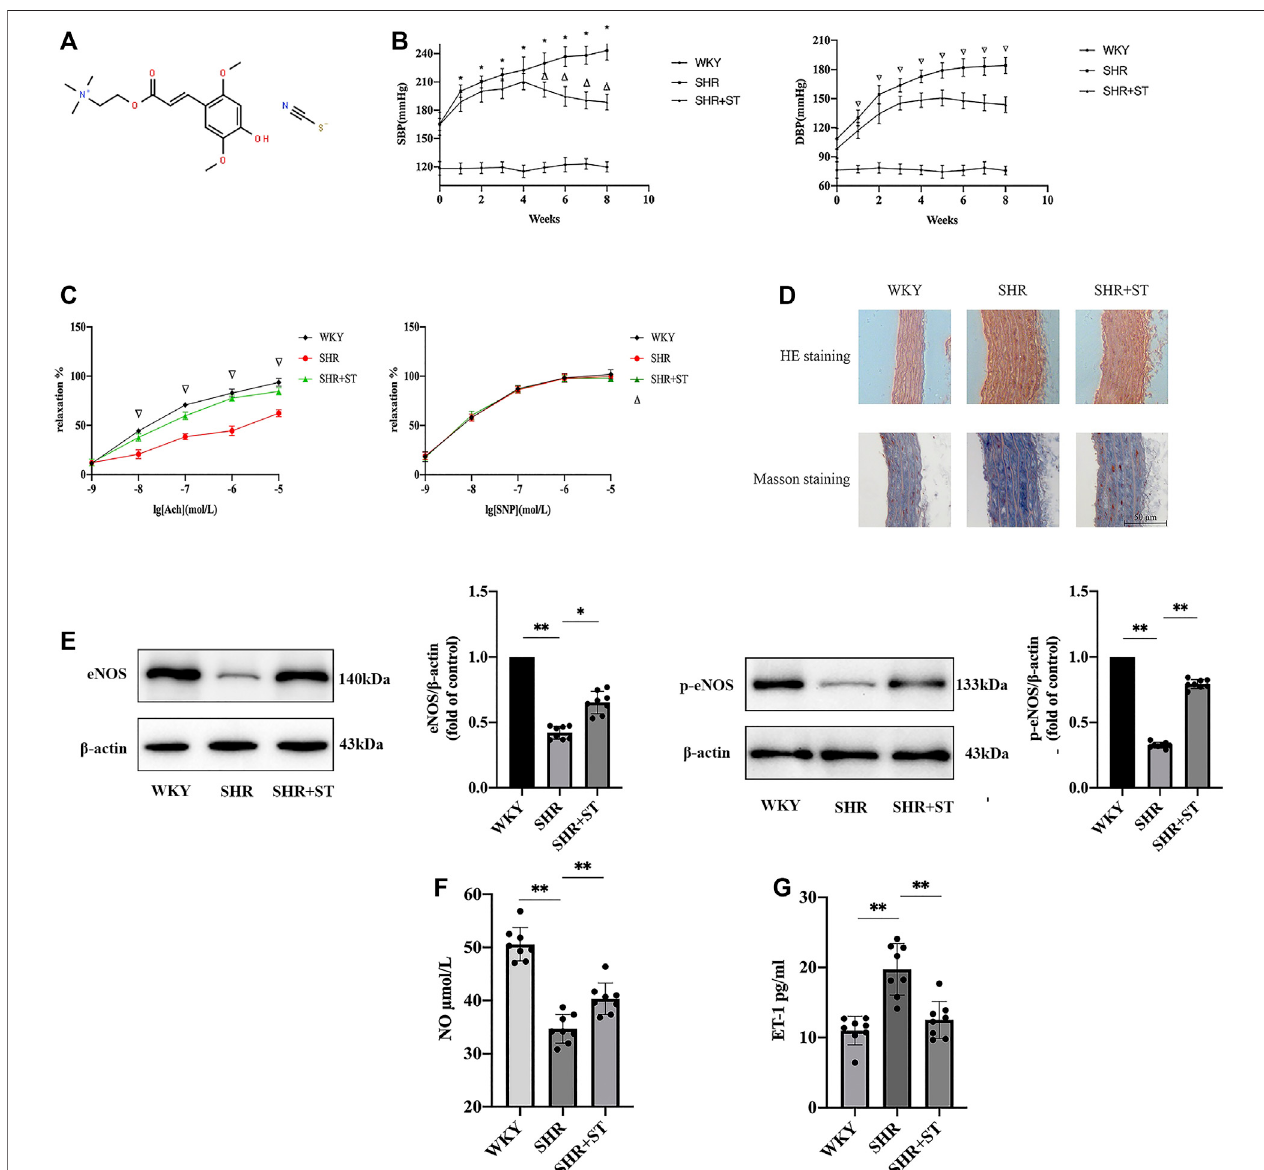
phosphotungstic-phosphomolybdic acid for 5 min, dyed